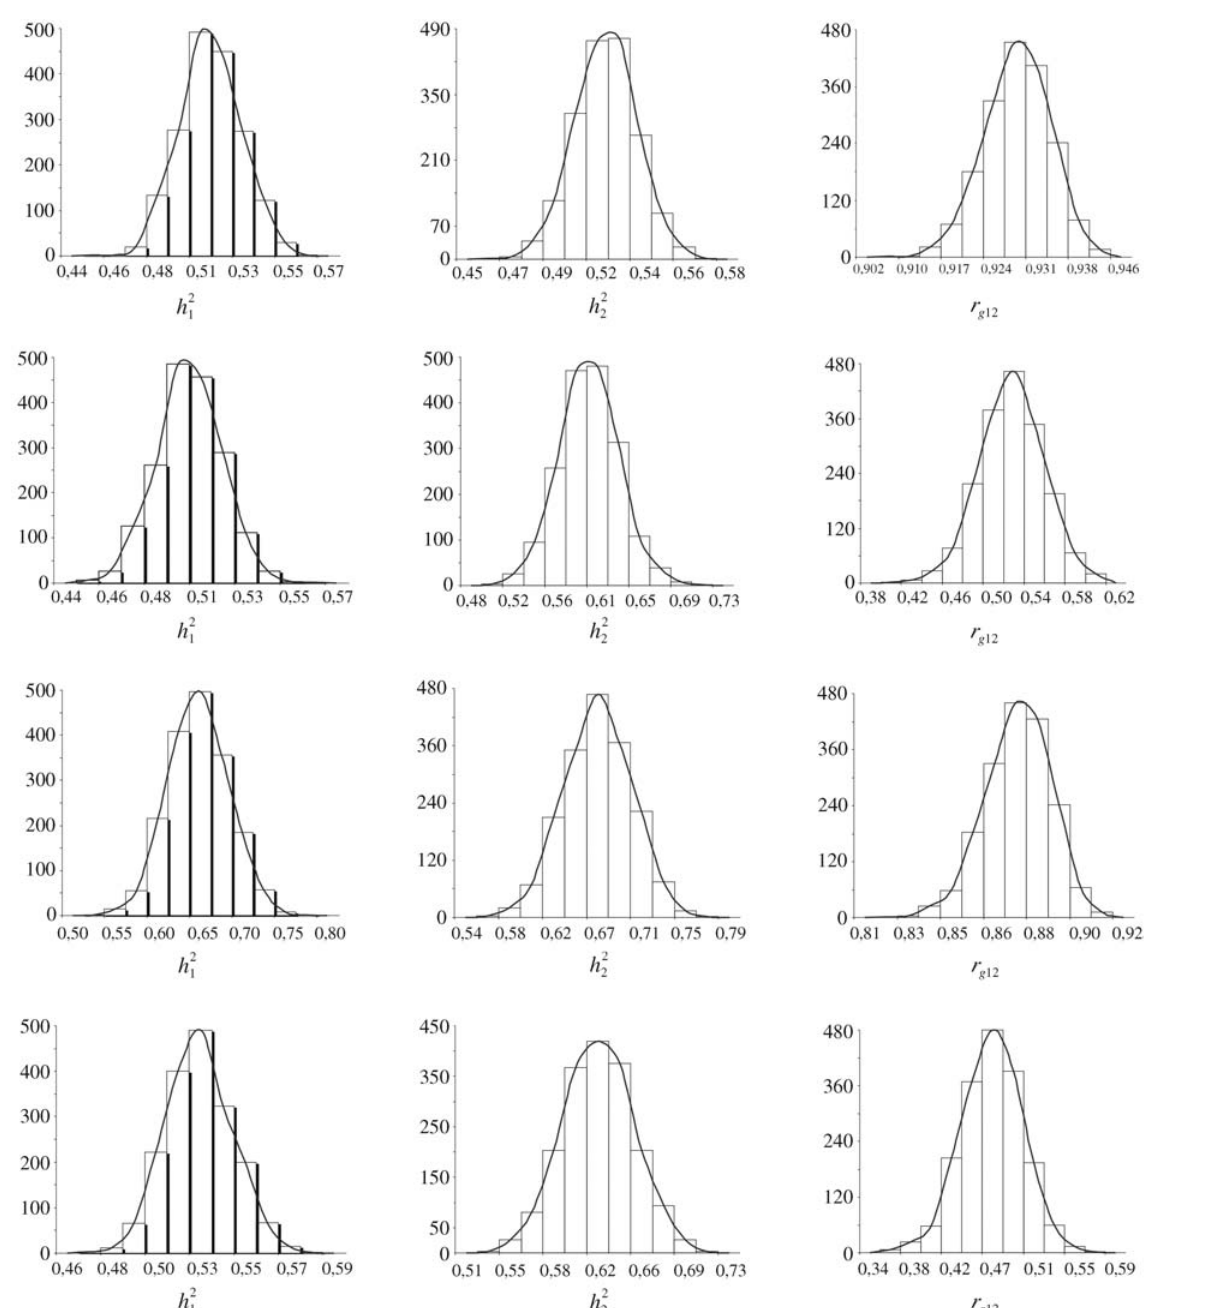
Figure 2 - Histograms of posterior densities estimates of genetic parameters for weight at 365 (1) and 450 (2) days of age (upper), weight (1) and scrotal circumference (2) at 365 days of age (upper middle), scrotal circumference at 365 (1) and 450 (2) days of age (lower middle) and weight (1) and scrotal circumference (2) at 450 days of age (lower) from a two-trait analyses using Gibbs